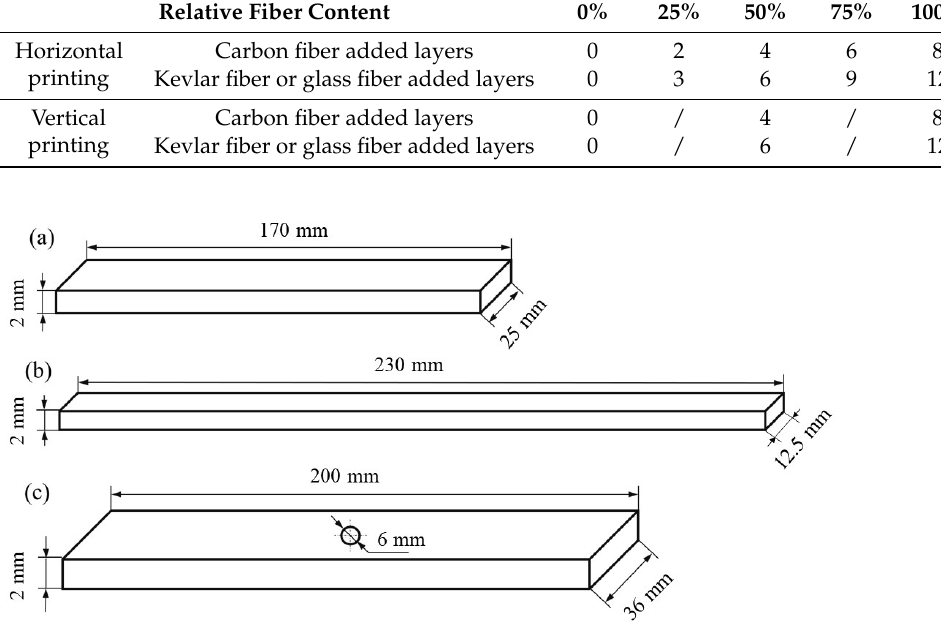
Table 3. The designed printed composites for the tensile and notch sensitivity test.